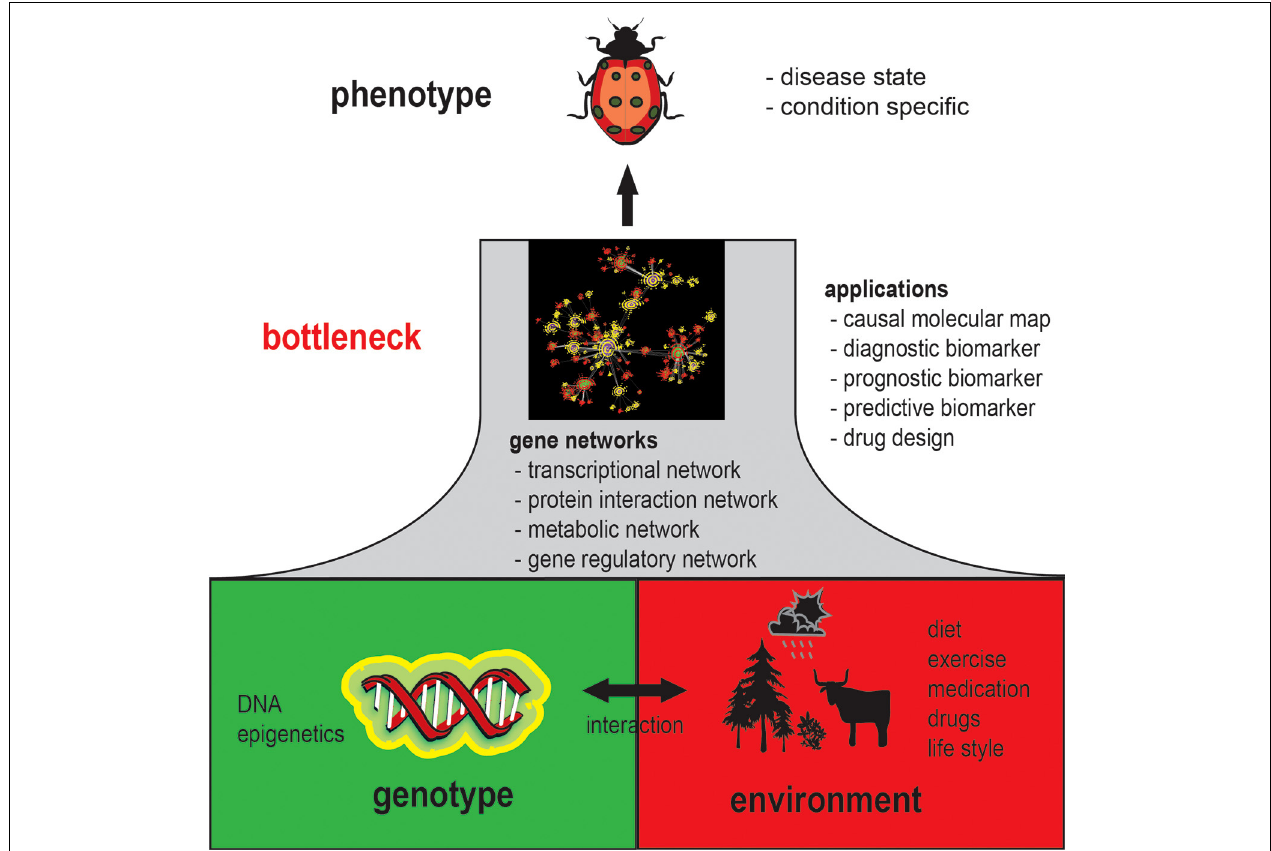
FIGURE 1 | Schematic overview of the general role gene networks play in understanding phenotypes.